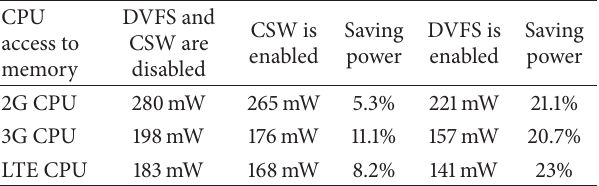
Table 2: Saving power with the DVFS.